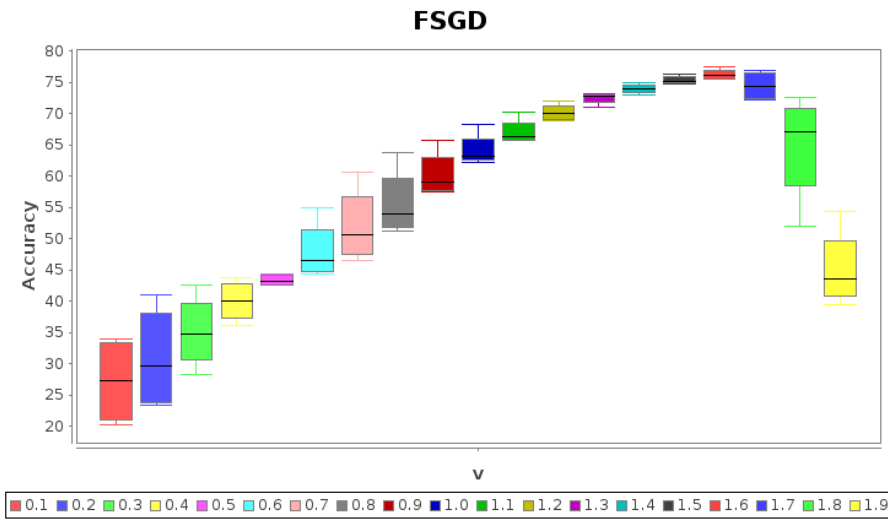
Figure 11. Experiment 3.1: FSGD cross-folding accuracies, K = 4 folds, ν ∈ [ 0.1,1.9 ] .